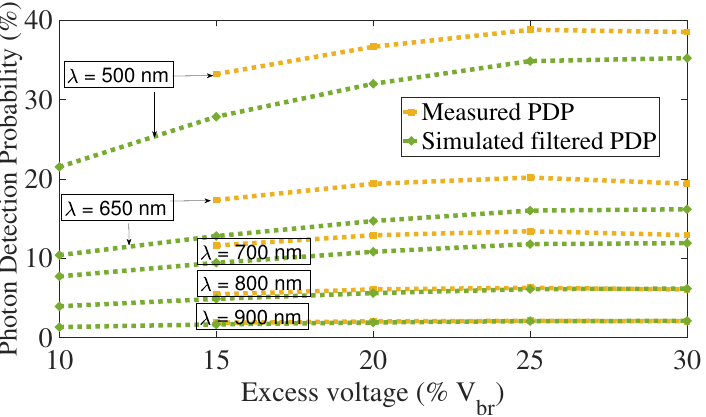
Figure 14. Photon Detection Probability as a function of excess voltage, without subtrate contribution. For the last data point, the measured PDP goes down while the excess voltage increases over 25%, we did not identify any reason for this as it should slightly increase as the simulated one. However, this decrease is small and could be related to slight errors in the